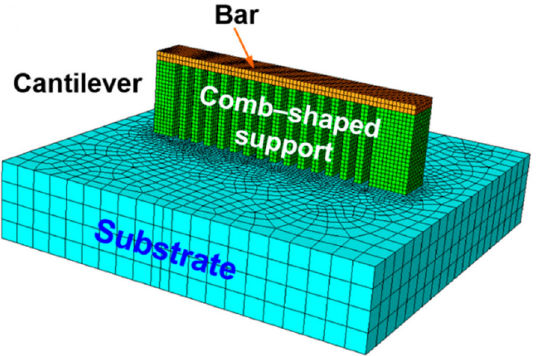
Figure 22. Three-dimensional model of a bar with comb-shaped support to measure the level of residual stresses [41].